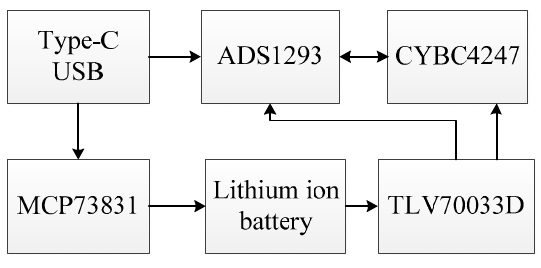
Figure 2. Block diagram of the fetal ECG collector circuit.